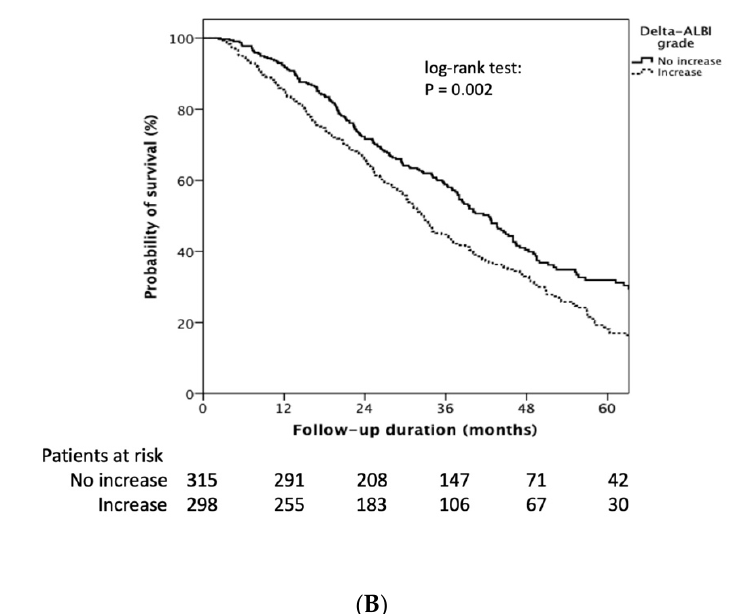
Figure 2. Kaplan–Meier estimates of survival rate stratified by ALBI grade and delta ALBI grade. ( A ) Patients with baseline ALBI grade I had longer OS than grade II/III (median 48.4 (95% CI: 40.9– 55.9) vs. 36.9 (95% CI: 33.4–40.4) vs. 23.9 (95% CI: 17.9–29.9) months, respectively, log rank p = 0.005).